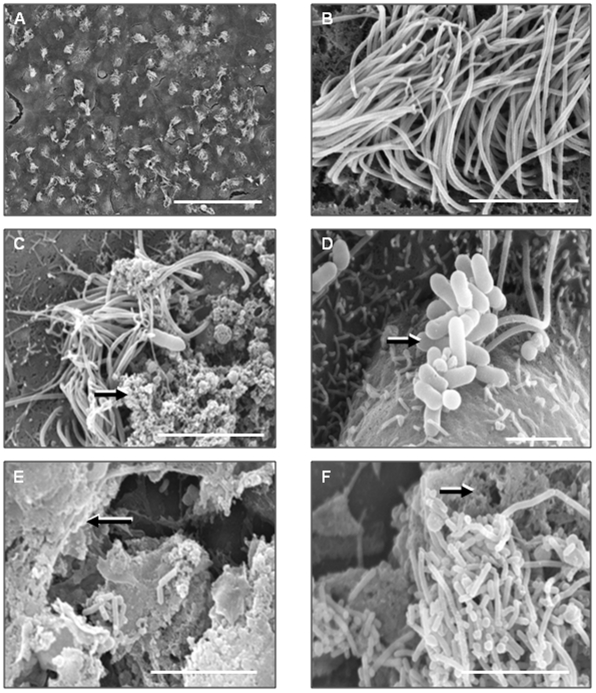
Scanning electron microscope images of Listeria on ciliated ependymal cells.(A) low magnification of rat ciliated ependymal cells in vitro. Scale bar represents 70 µm, (B) high magnification of a rat ciliated ependymal cell in vitro. Scale bar represents 5 µm, (C) L. monocytogenes strain 10403S on ciliated ependymal cell. The arrow shows areas of extracellular material. Scale bar represents 4 µm, (D) L. monocytogenes strain 10403S aggregate (arrow) on ciliated ependymal cells. No extracellular material is visible. Scale bar represents 2 µm, (E) presence of a thick layer of extracellular material on ciliated ependymal cells after incubation with L. monocytogenes strain EGDe. The arrow is pointing to an area with extracellular material. Scale bar represents 5 µm, (F) L. monocytogenes EGDe aggregate in the presence of extracellular material. The arrow is pointing to an area of extracellular material. Scale bar represents 5 µm.